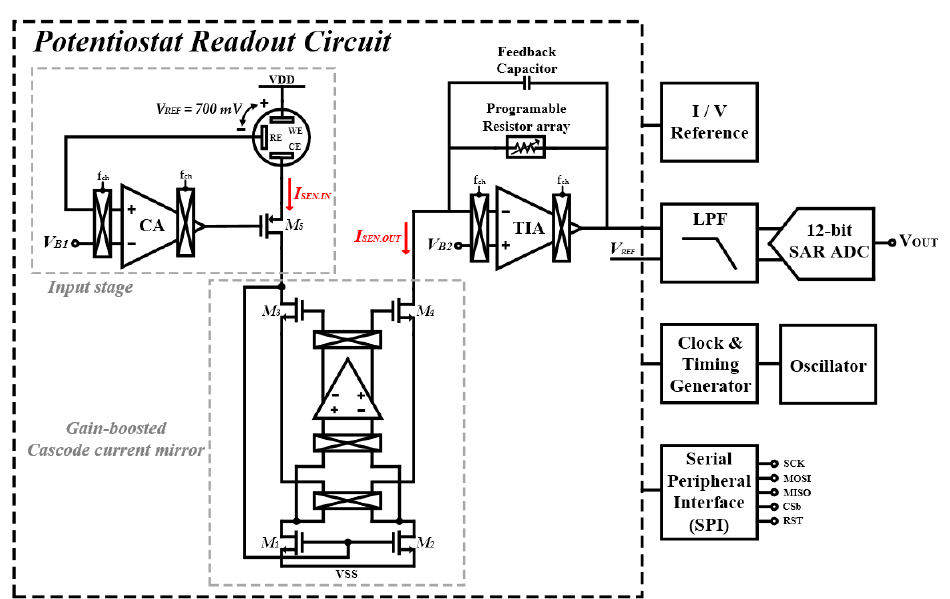
Figure 3. Top architecture of proposed current mirror based potentiostat readout circuit.